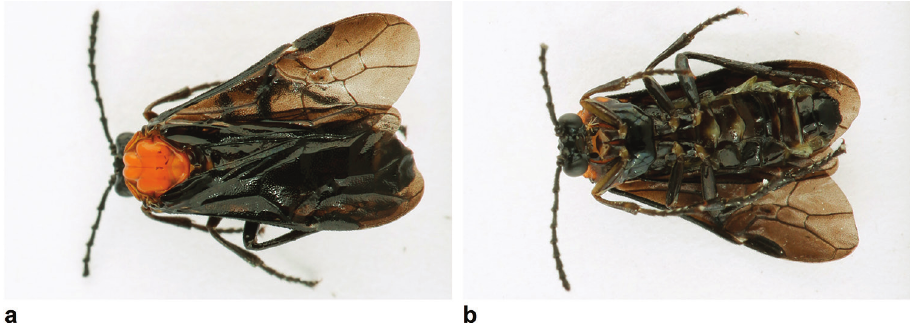
Figure 11. Decameria sp., male (P4238.B), body length 8.0 mm. a Dorsal view b ventral view. Decameria sp. Fig. 11 Material. Nanegal, Reserva Biológica Maquipucana, 00°08'N, 078°38'W, 1300m, 25.11.2016, P4238.B (1 ♂ ), leg. A. Pauly, J.-L. Boevé.